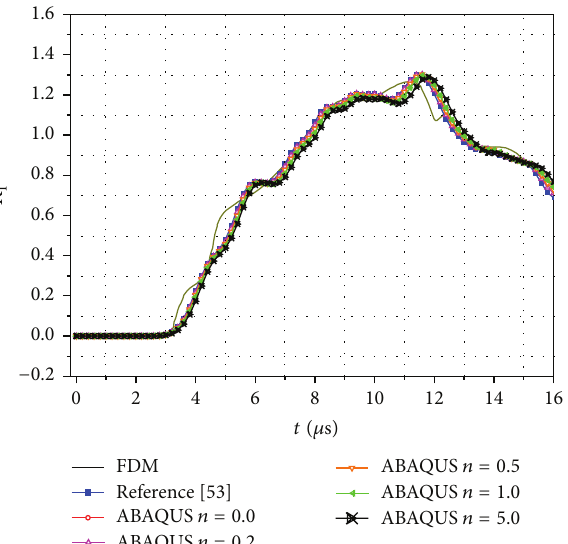
Figure 8: Dynamic stress intensity factor 𝐾 I of inclined-crack functionally graded plate with different shape factors.